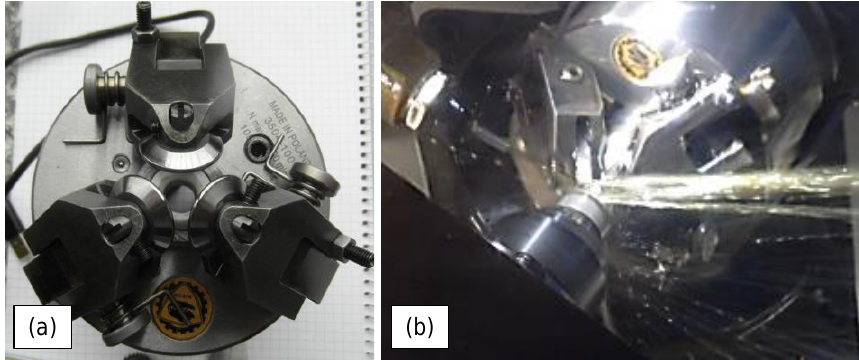
Table 1. Experimental